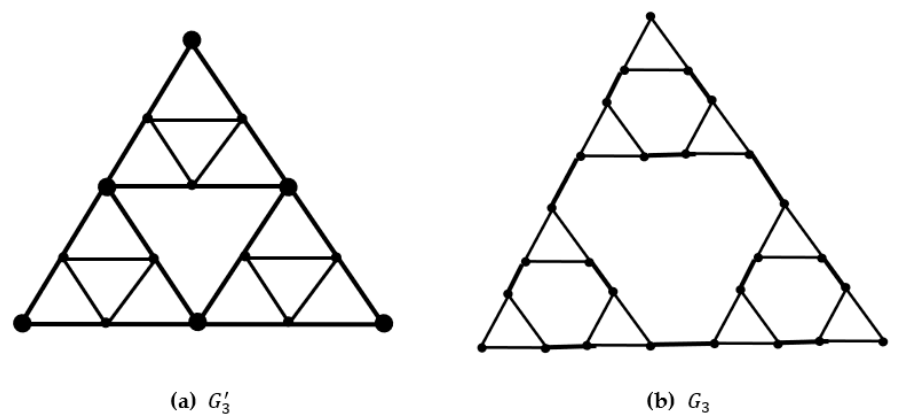
(cid:48) ; ( b ) canonical prefractal graph G 3 3